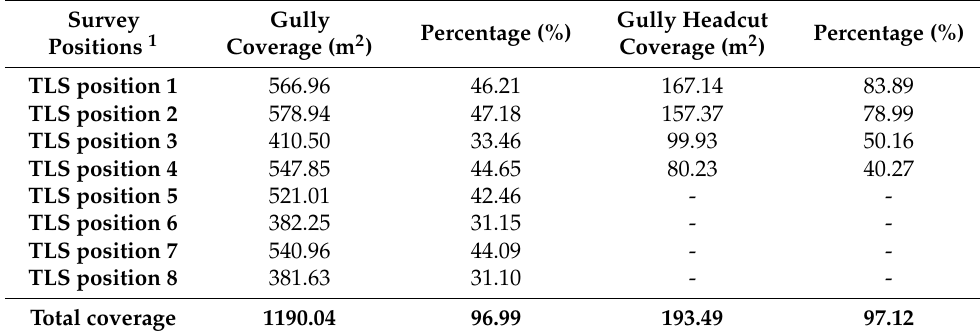
Table 1. Planned coverage of the study area from eight chosen optimal TLS